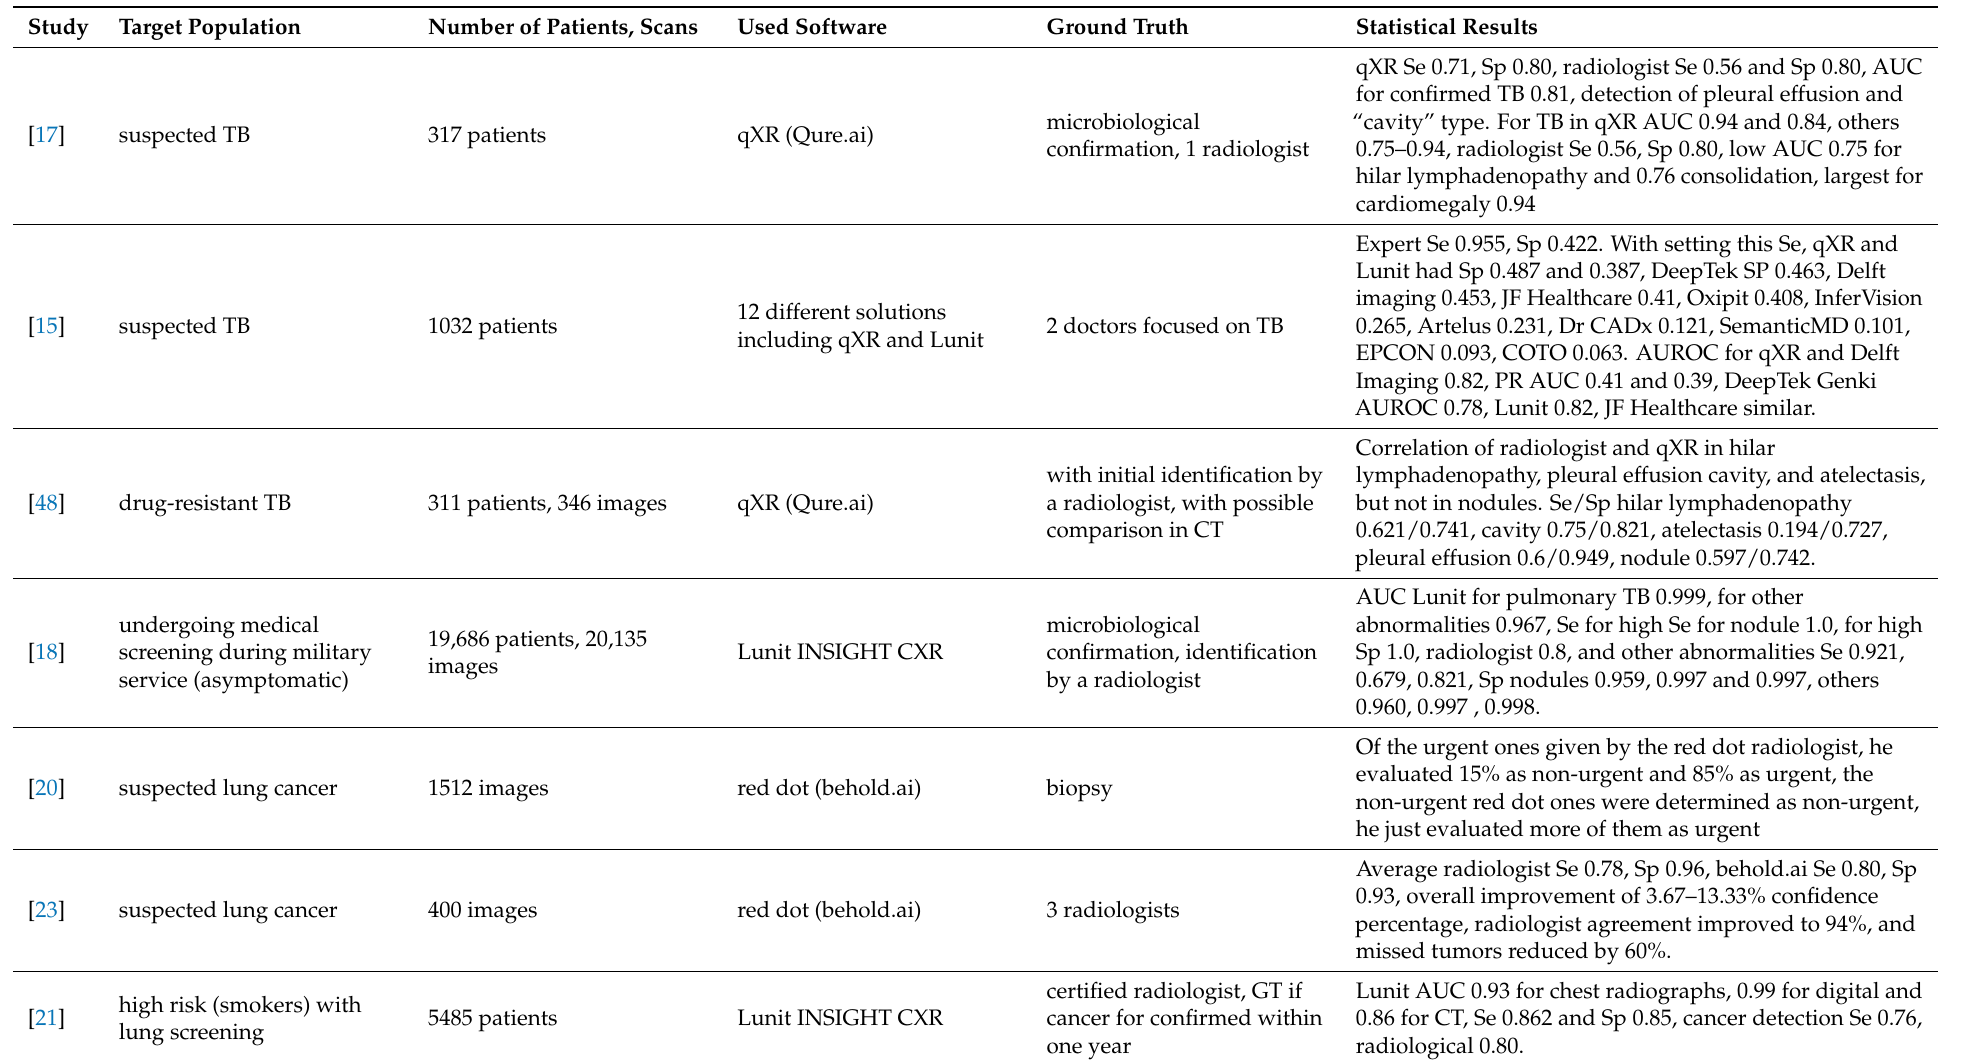
Table A1. Analysis of existing solutions and publications on CXR computer-aided